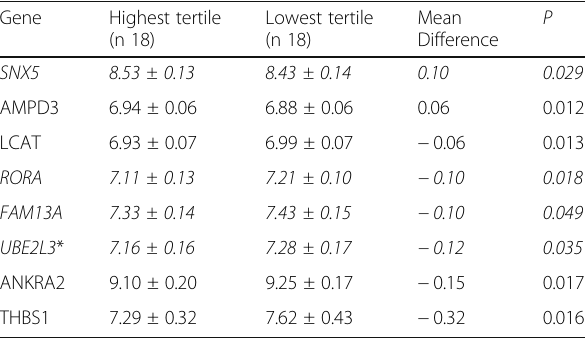
Table 4 Differentially expressed genes between subjects in the highest and lowest plasma n-3 tertile